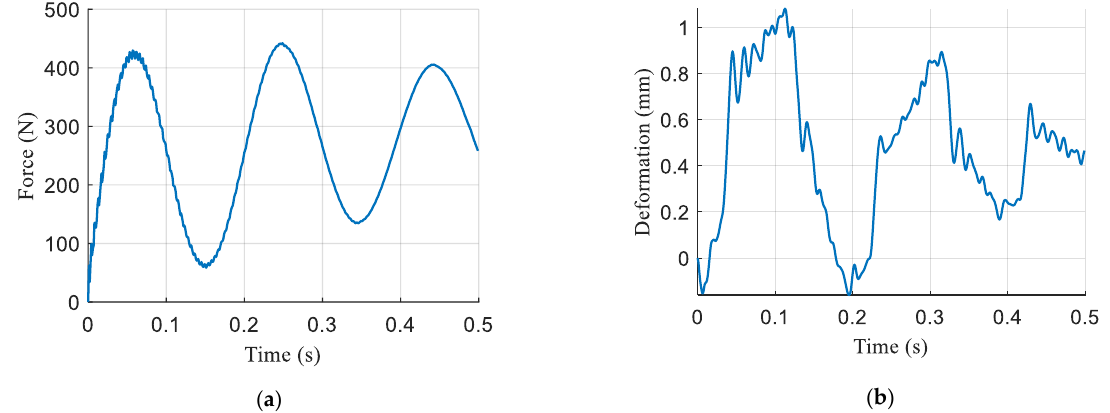
Figure 9. Contact force and surface deformation in the time domain. ( a ) Contact force; ( b ) surface deformation.